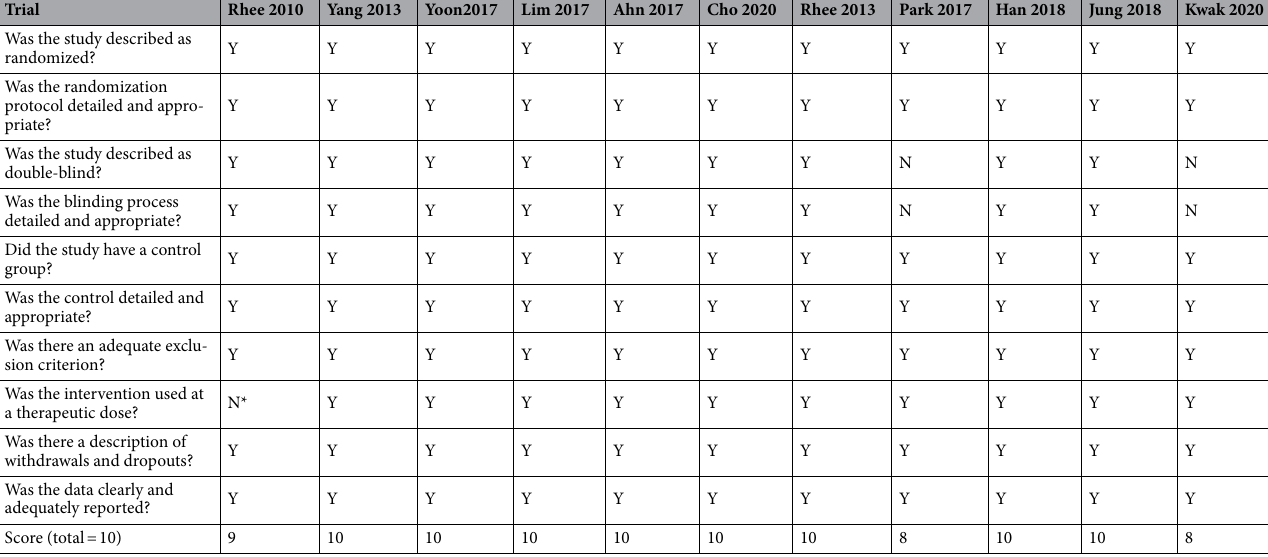
Table 4. Modified Jadad scores of the 11 selected RCTs. Y Yes, N No. *Dose determining study for 50 mg, 100 mg, and 200 mg gemigliptin versus placebo